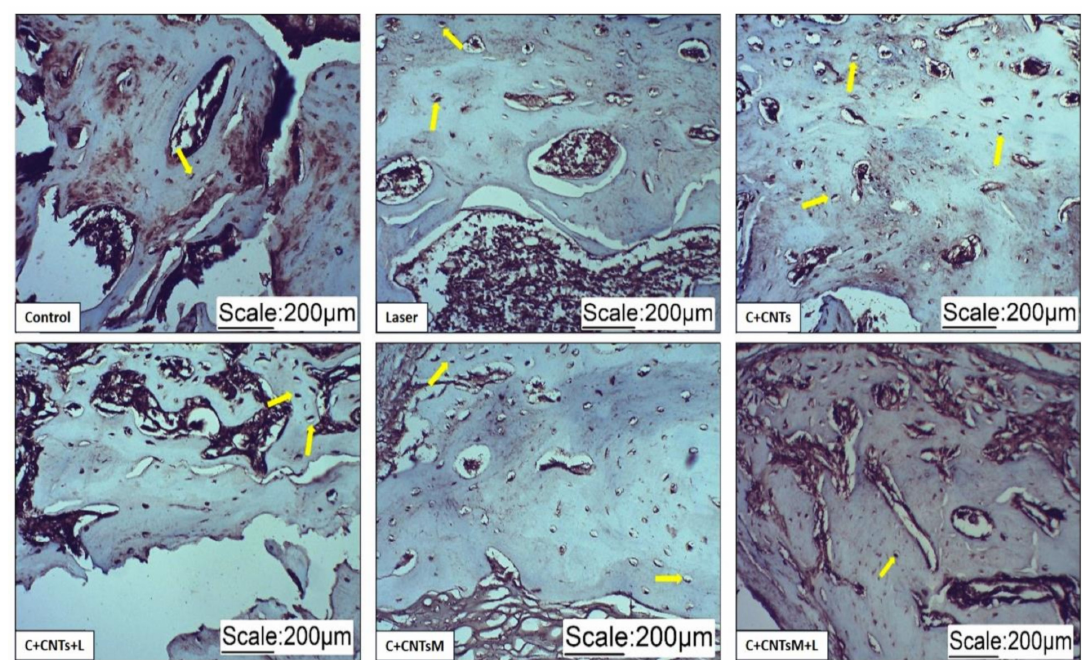
Figure 9. Optical microscope images of osteocalcin immunostaining of the groups studied. Osteocytes were identified by the expression of osteocalcin. The yellow arrows indicate the labeling of osteocytes.